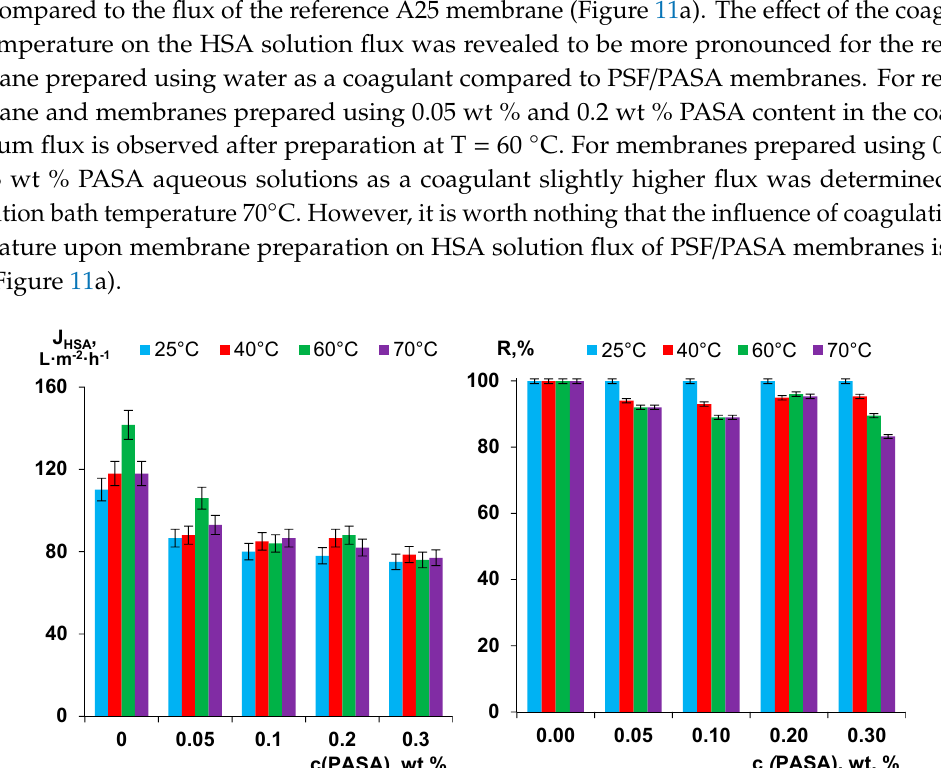
Figure 11. Human serum albumin (HSA) solution flux (J HSA ; measured at trans-membrane pressure of 1 bar) ( a ) and HSA rejection (R) ( b ) of PSF membranes prepared at different PASA concentration in the coagulant at different temperatures.